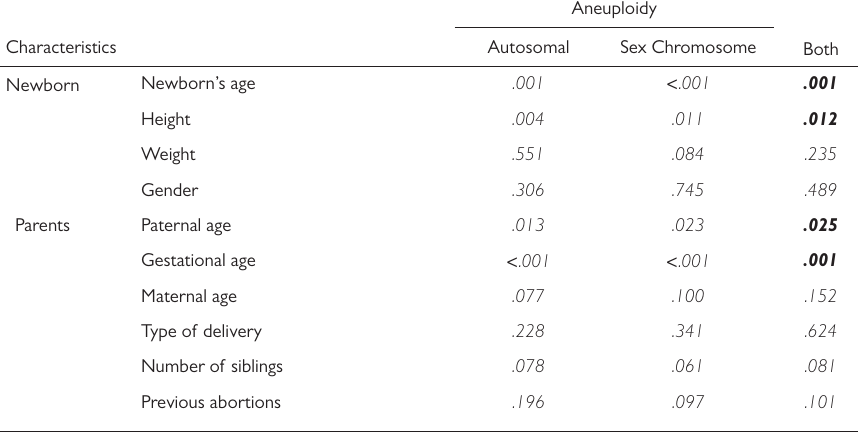
Table 2. Associations Between Aneuploidies and Main Characteristics of Newborns and